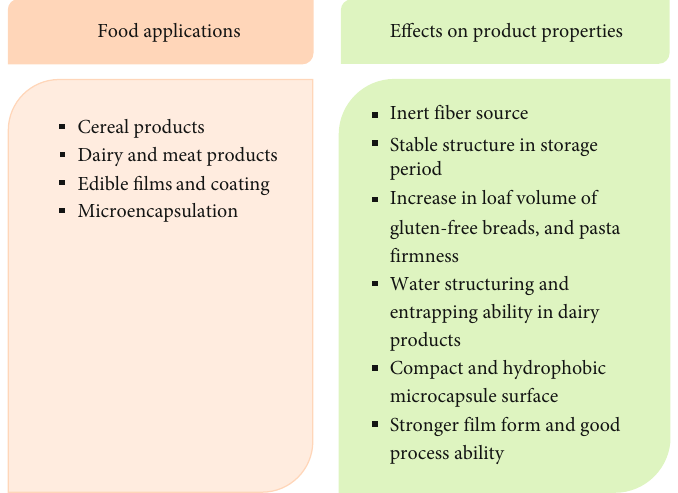
Figure 3: Resistant starch applications and quality e ff ects in some food products.